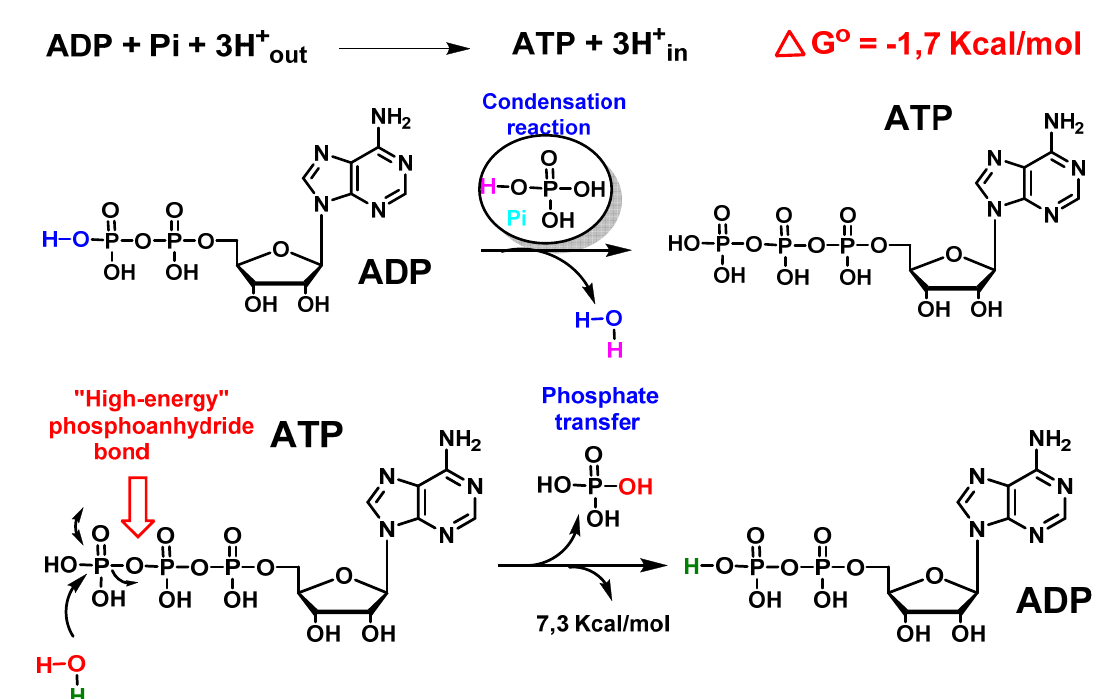
Figure 3. ADP conversion to adenosine triphosphate (ATP) by condensation reaction involves the transport of H + protons across the mitochondrial inner membrane to the intermembrane space, whereas the reaction to produce ATP from ADP have a negative Gibbs free energy, ∆ G ≤ 0, and occurs spontaneously.